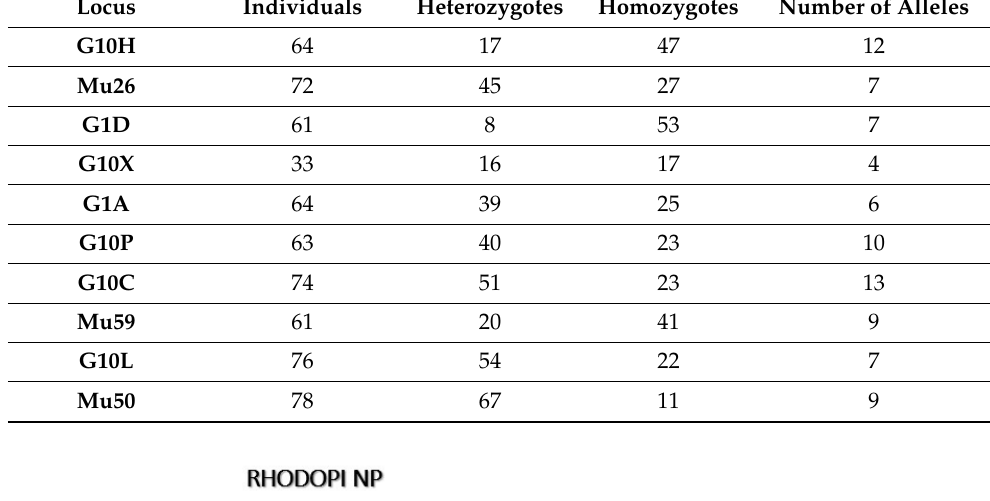
Table 6. Number of homozygotes, heterozygotes, and alleles that are present at each locus (Rhodopi NP).